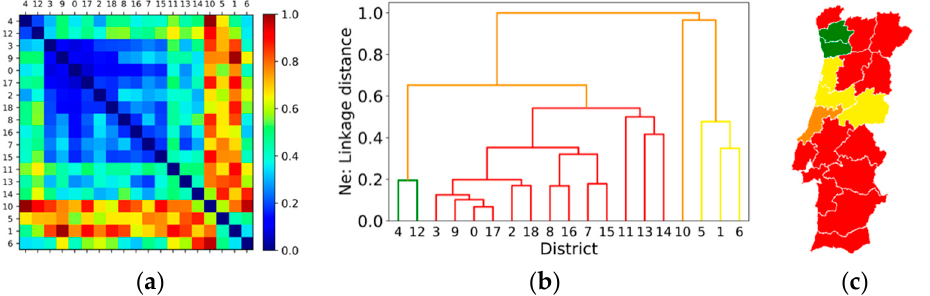
Figure 11. Negligent causes (Ne): ( a ) Dissimilarity matrix; ( b ) Clusters by relative annual profile of distribution; ( c ) Clusters in geographic location (cophenetic coefficient: 0.86). distribution; ( c ) Clusters in geographic location (cophenetic coe ffi cient: